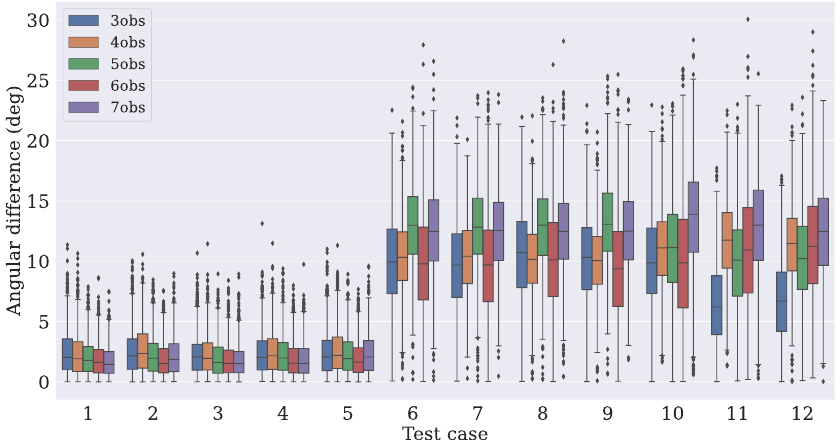
Figure 8. Dispersion of the absolute angular difference when using a dropout rate of 15%.